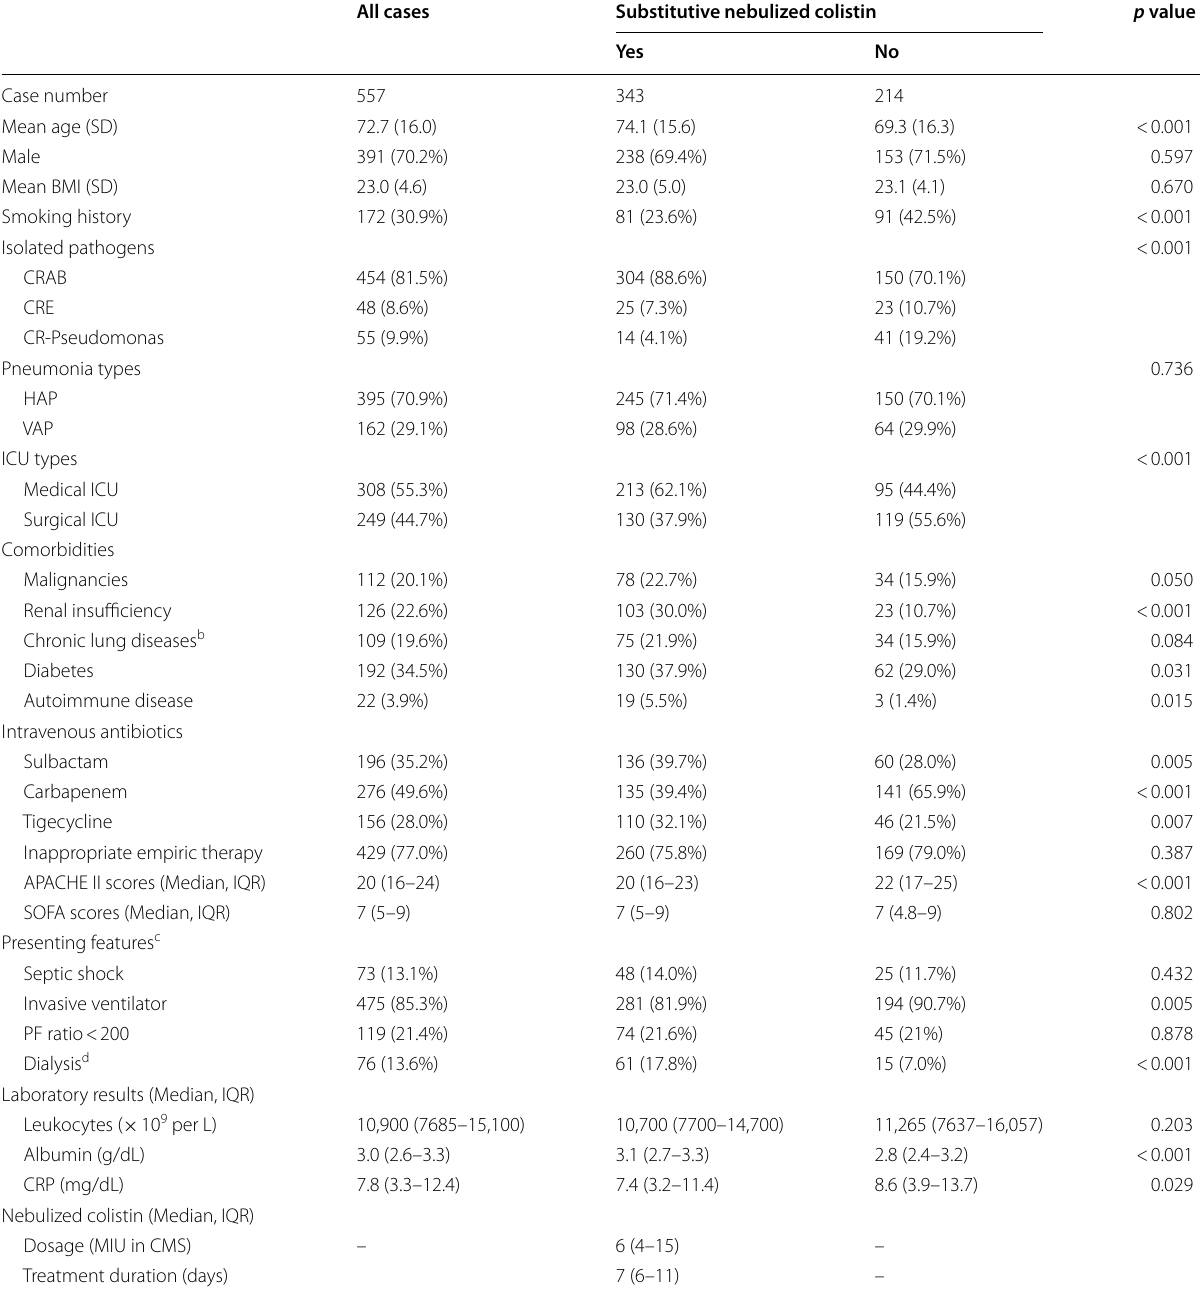
Table 1 Demographic characteristics and disease severities of ICU patients with nosocomial pneumonia treated with and without nebulized colistin in substitutive strategy